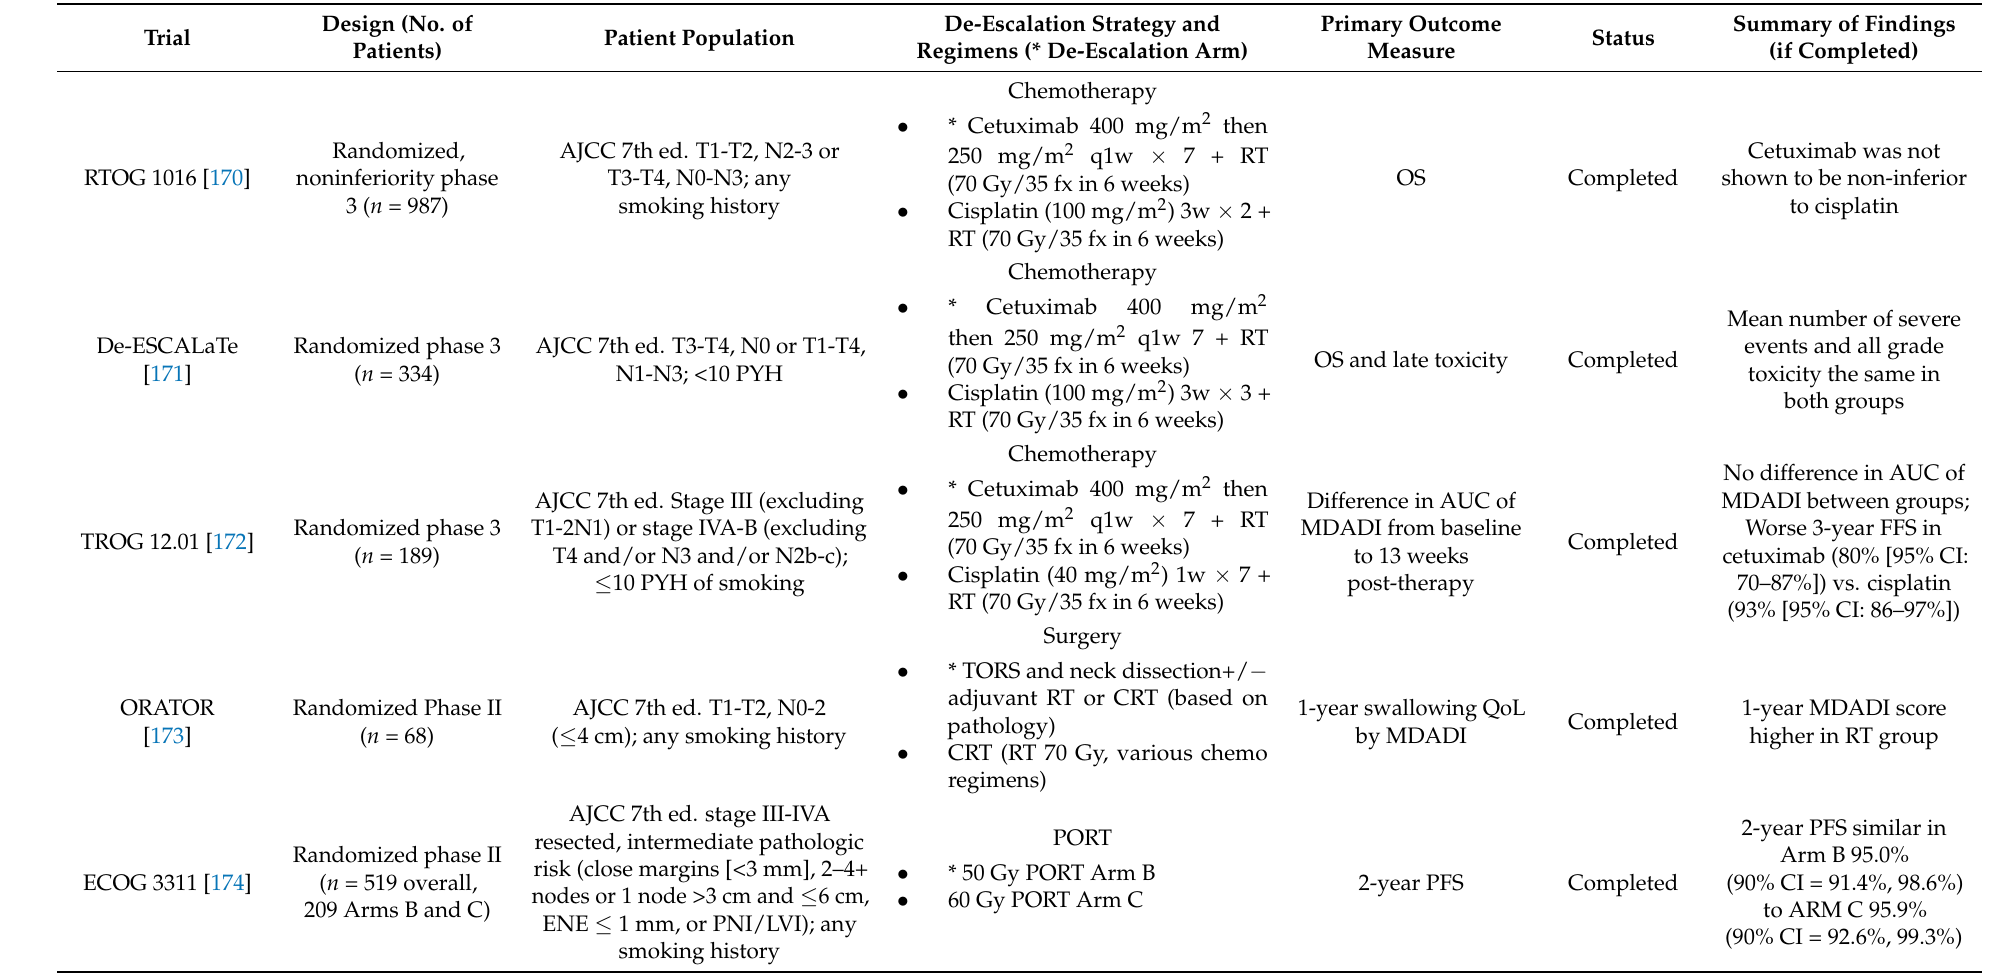
Table 3. Key de-intensification trials in HPV+